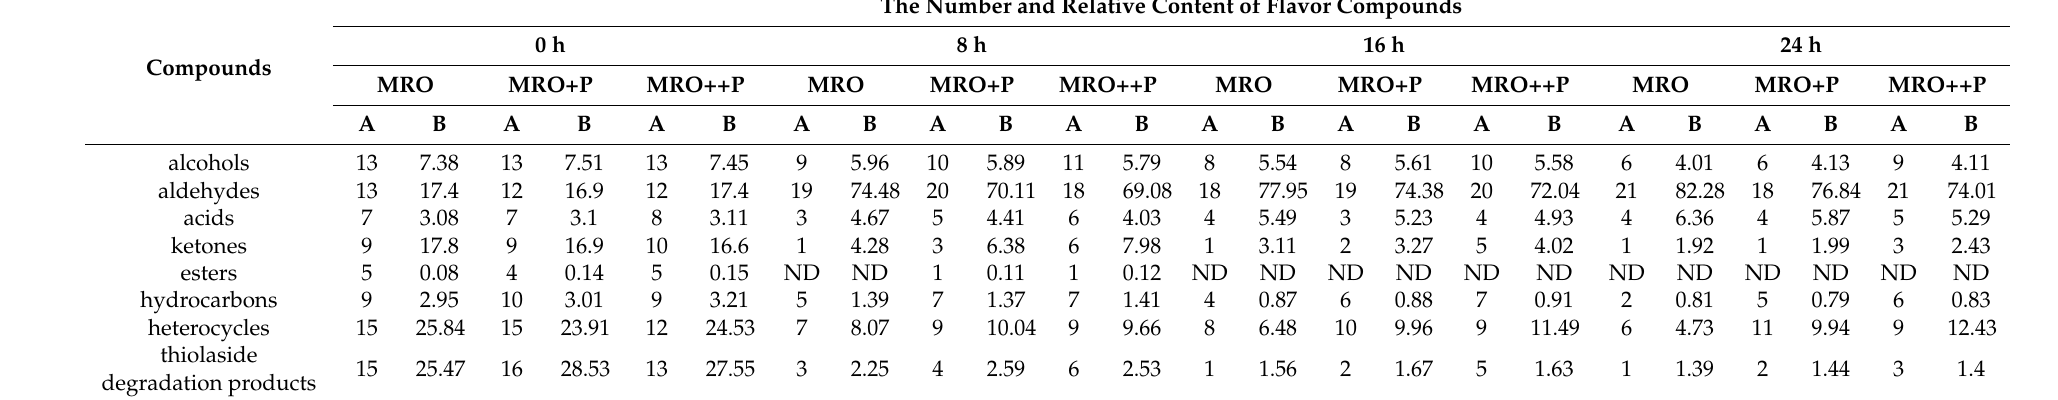
Table 3. Effects of HCP on the kinds and concentrations of flavor compounds during frying.